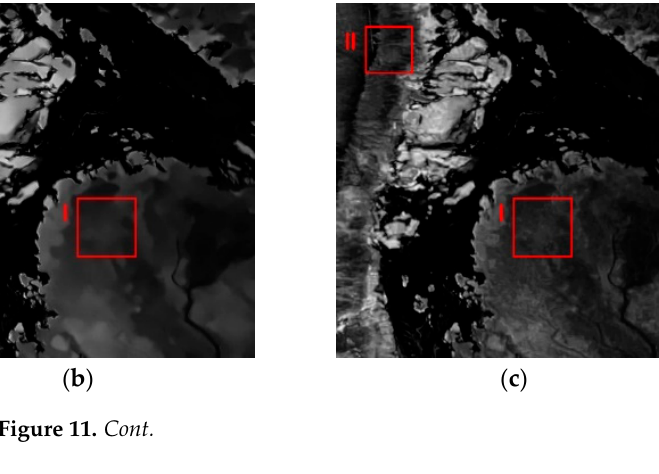
Figure 10. Despeckle results of different methods for the Flevoland SAR image: ( a ) original; ( b ) PPB; ( c ) SAR-BM3D; ( d ) ID-CNN; ( e ) proposed.